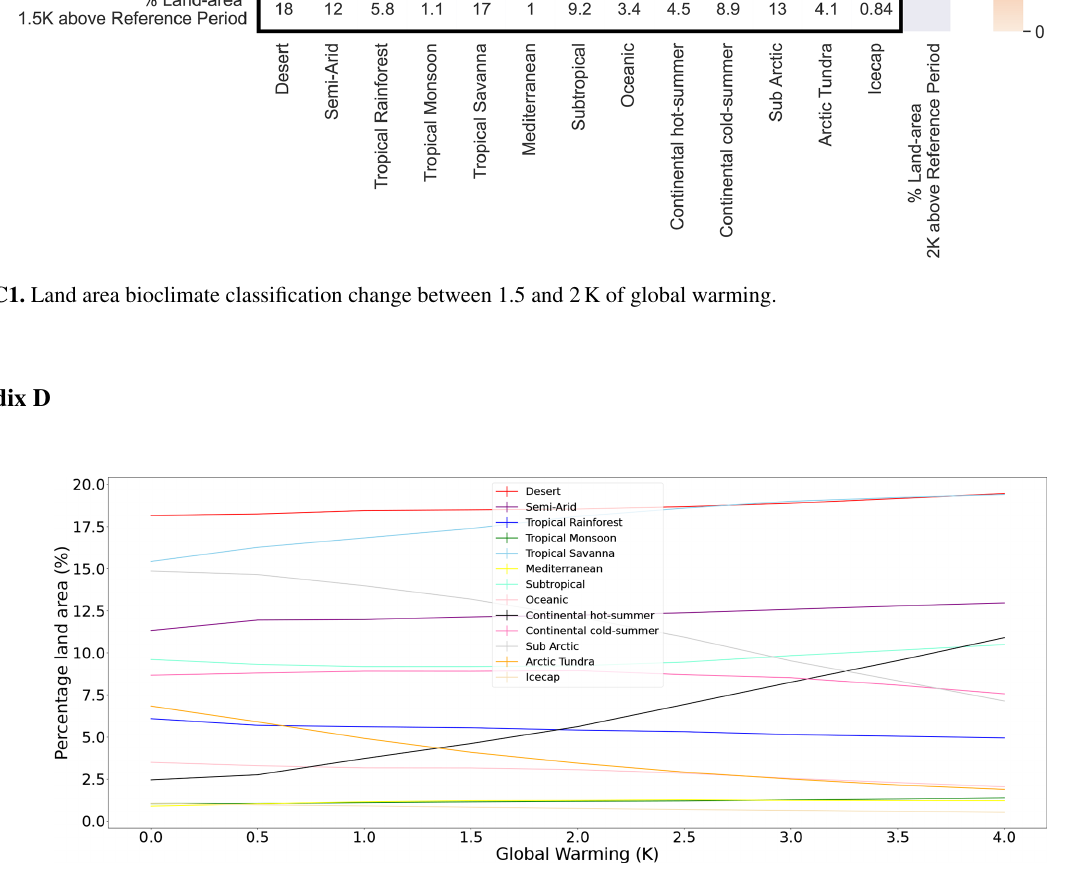
Figure D1. Land area distribution of individual streamlined classifications. Classifications that show large growth in their coverage include continental hot summer and tropical savanna. Classifications that show major reductions include ice cap, arctic tundra, and subarctic.